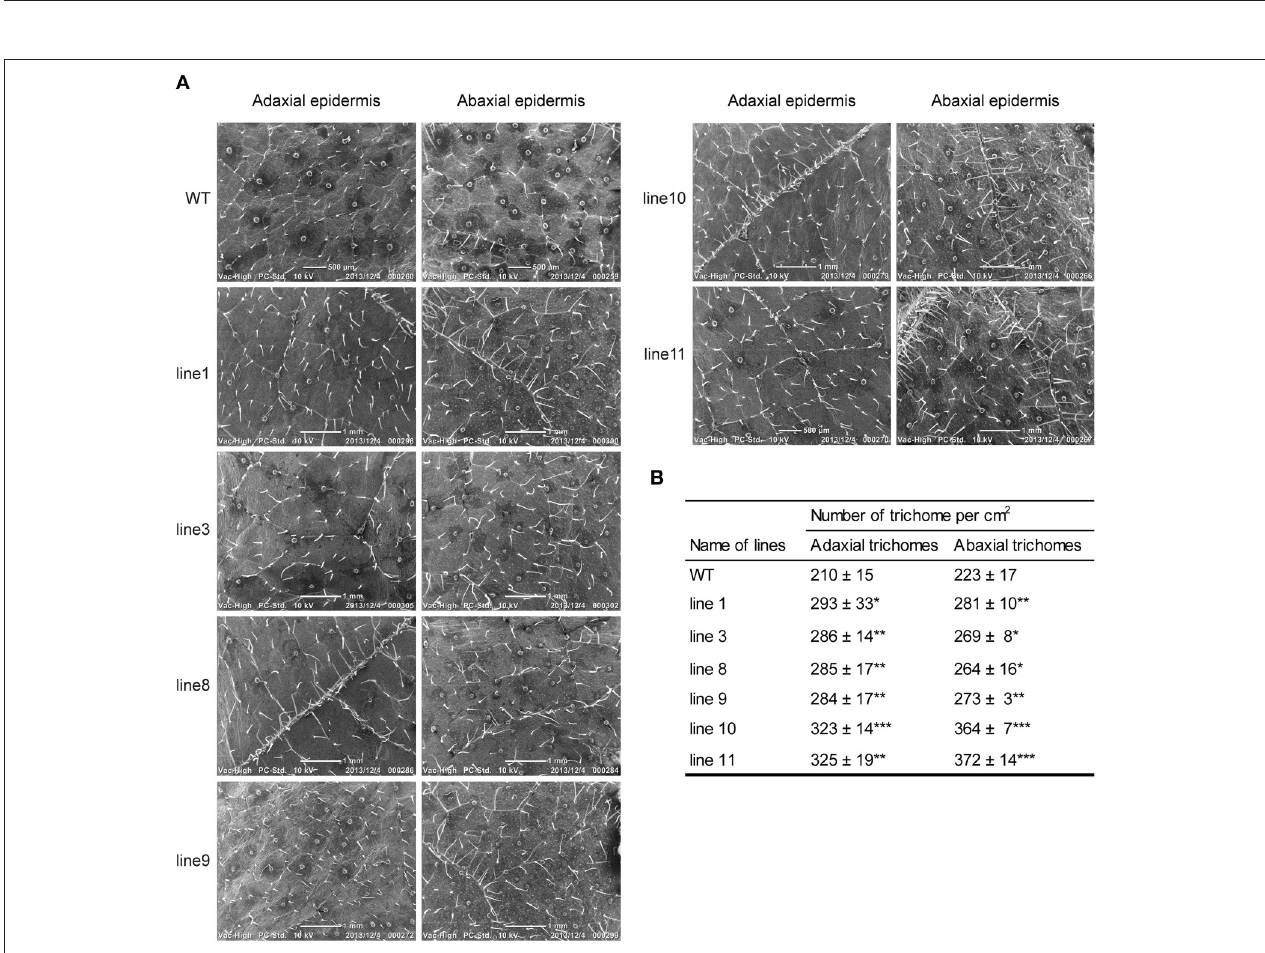
FIGURE 6 | Foliar trichome observation in WT and transgenic lines ( 35S::BpMYB106 ) of B. platyphylla by SEM (A) adaxial and abaxial epidermis. (B) Quantity statistics of trichome between WT and transgenic lines. Errors indicate the mean ± SE of three replicate reactions, and statistically significant differences are indicated ( * P < 0.05 , ** P < 0.01 , and *** P < 0.001 by two-tailed t -test and one-way ANOVA). WT: wild-type plant; lines 1, 3, 8, 9, 10, and 11: transgenic lines ( 35S::BpMYB106 ).